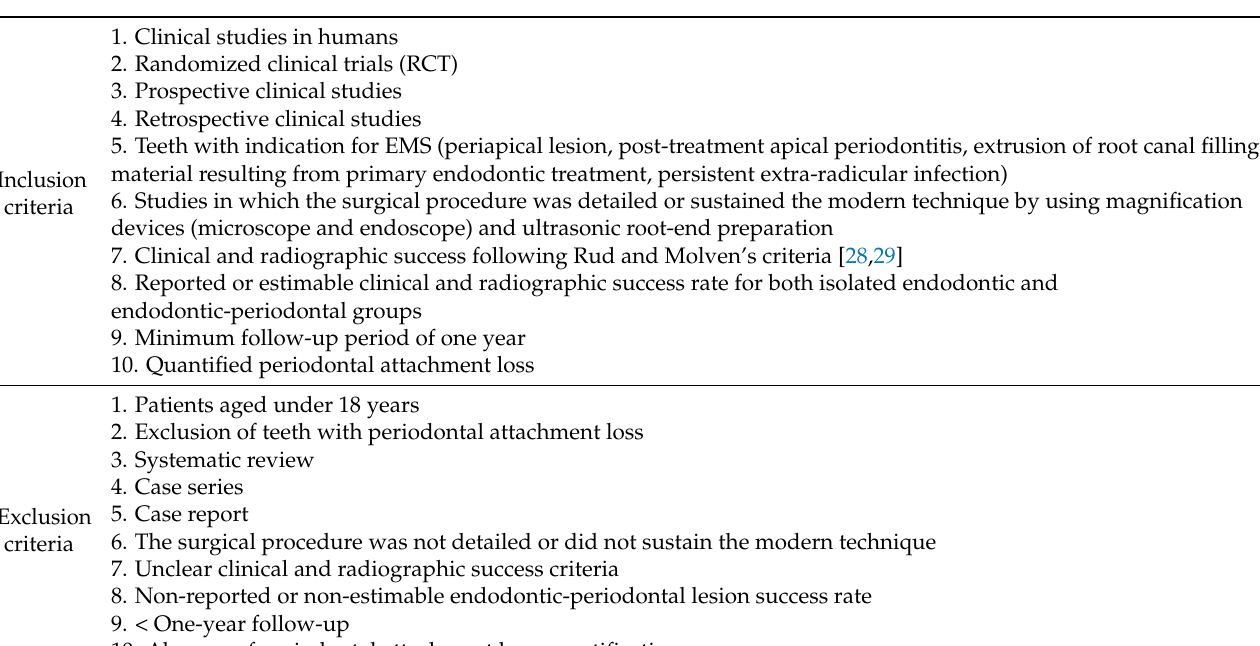
Table 1. Inclusion and exclusion